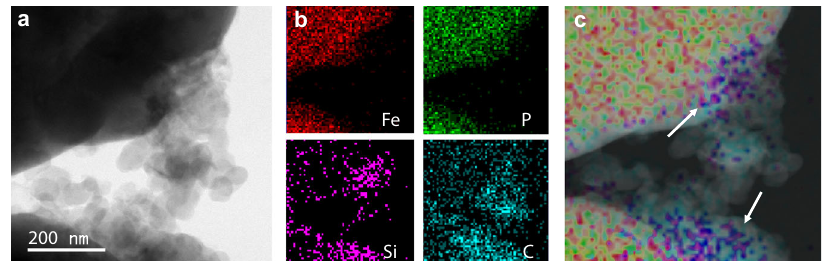
Fig. 2 High-magni fi cation elemental mapping of SCB electrode heated to 500 °C. a Bright- fi eld TEM image of the interface between active LFP particle and conductive carbon. b Elemental mapping results con fi rm the location of silicon, carbon, and active materials. c Overlay demonstrating the localization of silicate at the active material interface.